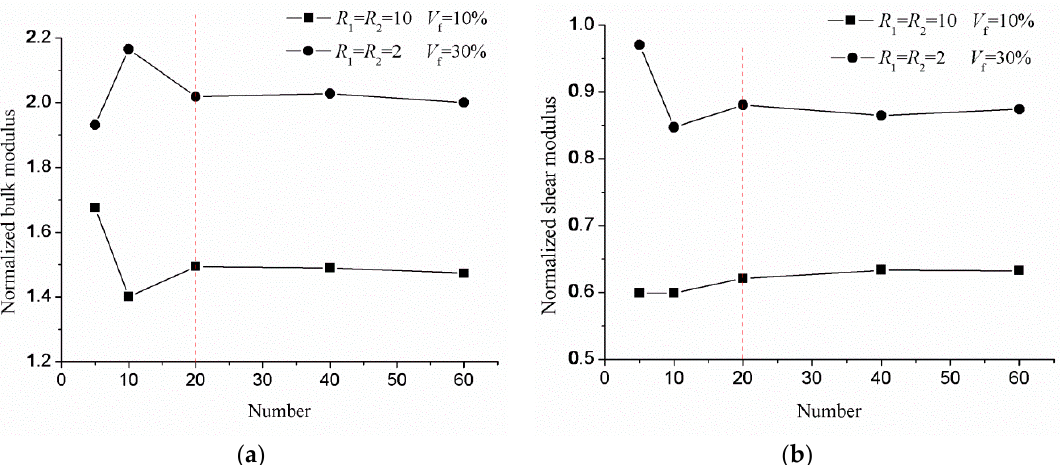
Figure 8. The variation of the normalized modulus with the number of inclusions for the volume fraction being fixed: ( a ) bulk modulus; ( b ) shear modulus.